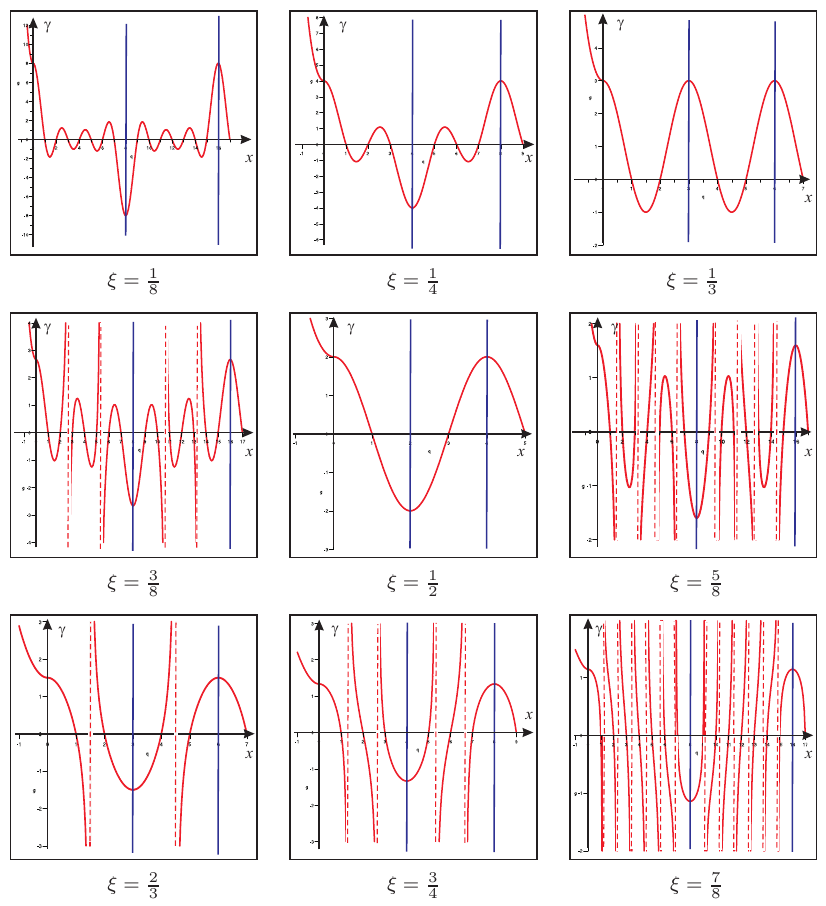
Figure 13. Generalized real functions γ ( xπ ) for various ξ